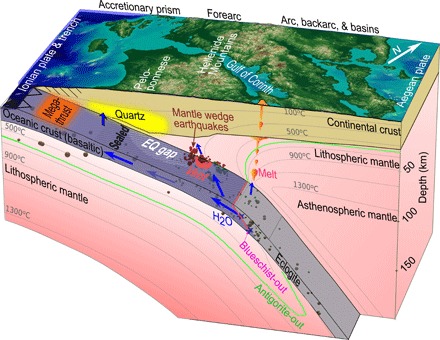
Schematic showing fluid migration paths between the sources and sinks of water in the Hellenic subduction zone.The fluids originate from dehydration reactions in the slab and flow either toward the melting zone in the mantle or updip below a sealed plate interface. Fluids that flow updip trigger earthquakes (EQ; black circles) as they migrate along the slab toward the overriding crust (where they precipitate into quartz) or if they escape via localized vents into the cold mantle wedge corner (where they cause unusual mantle wedge earthquakes). Reduced fluid flow in the subducting crust updip of these vents leads to reduced seismicity. Other subduction zones with cold interfaces and dry mantle wedges (see Fig. 4) exhibit similar fluid migration patterns.